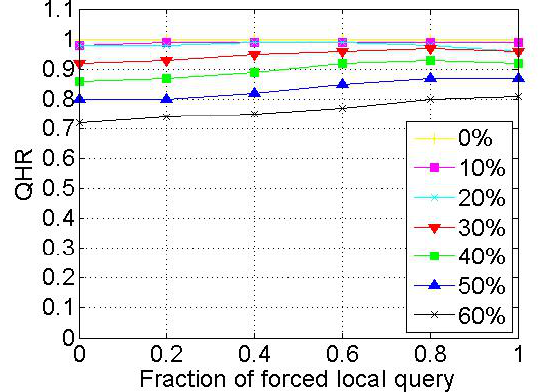
Figure 14. The QHR for SPEQs and fraction of forced local